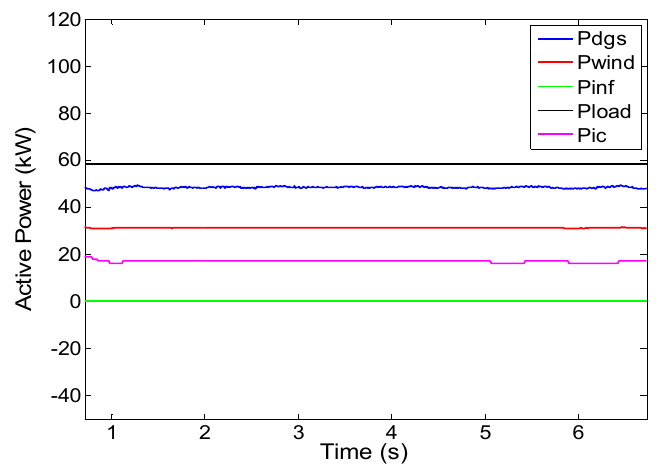
Figure 20. AC active power flow in the second case.